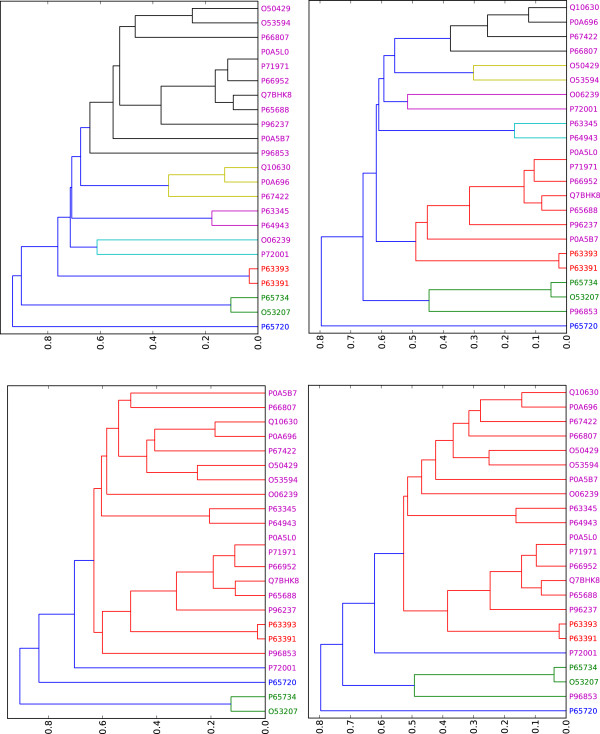
Clustering results obtained by running the hierarchical clusteringprogram. Clustering results obtained by running the hierarchicalclustering program using different similarity metrics under the DaGO-Fun tool.Protein label is colored according to the process in which the protein isinvolved. Magenta for proteins involved in GO:00051409, blue for GO:0071236,green for GO:0044255 and red for GO:0052099. (1) Using GO-universalapproach. (2) Using Wang et al. approach. (3) Using Resnikapproach. (4) Using Li et al. approach.